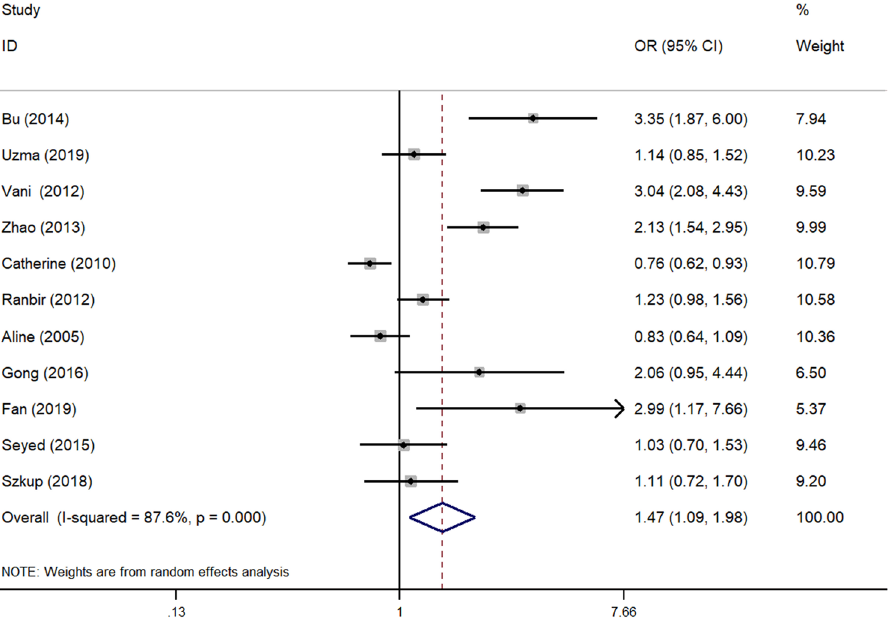
Figure 2. Forest plot of the association between -308G/A polymorphism of TNF-α gene promoter and MS risk under allele model. OR odds ratio, CI confidence interval.